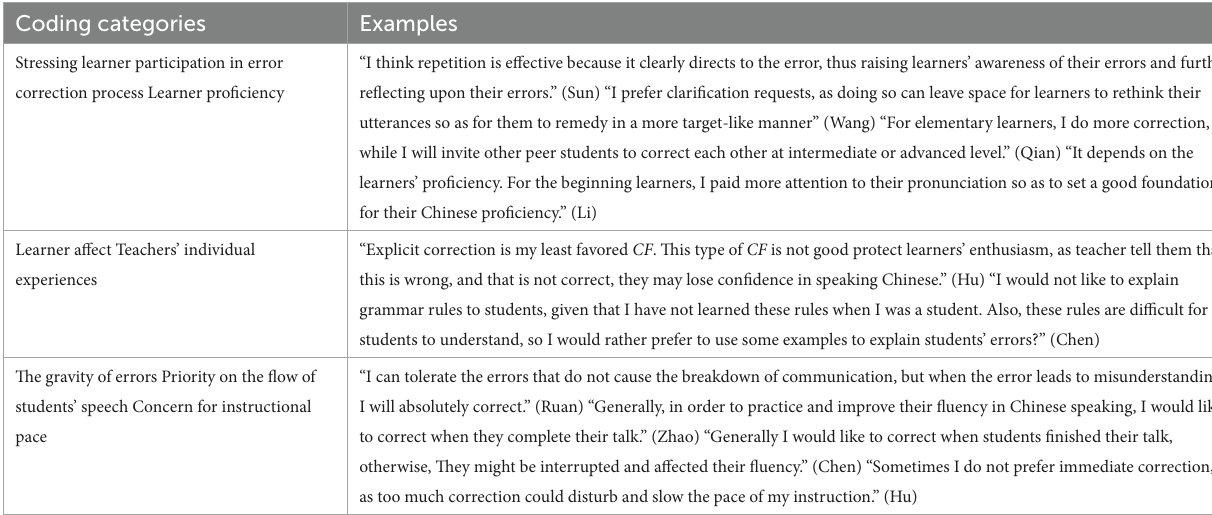
TABLE 6 Comments from the teachers for their CF preferences.